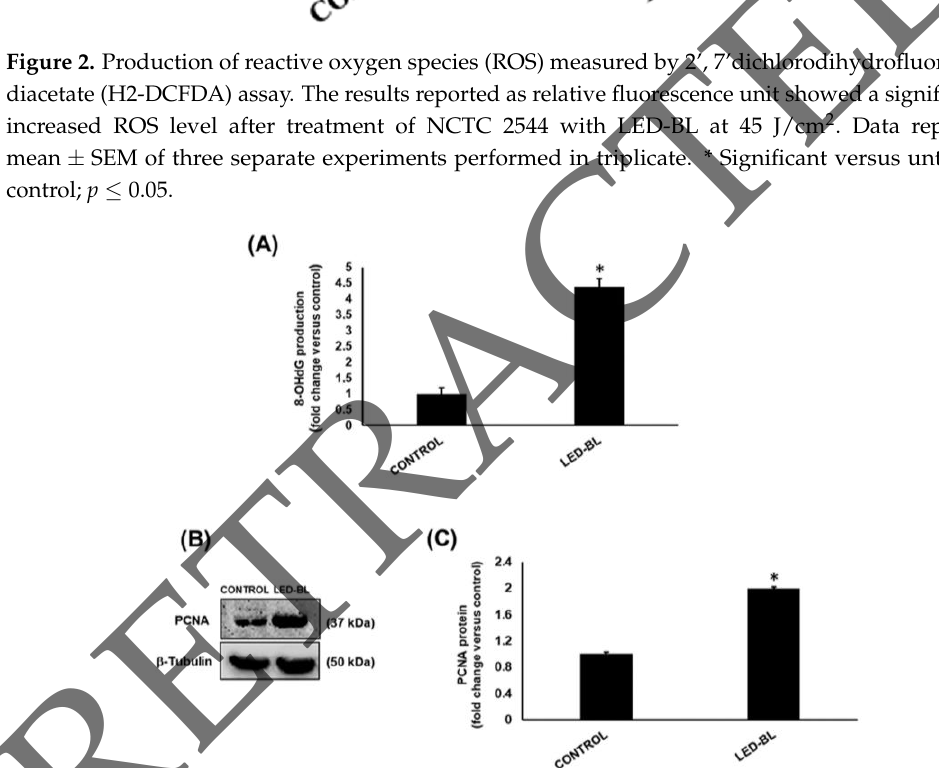
Figure 3. Determination ( A ) of 8-OHdG by immunofluorescence, and ( B , C ) of PCNA protein by Western blot in NCTC 2544 untreated or treated with LED-BL at 45 J/cm 2 . ( A , C ) protein expression calculated as fold change versus untreated control (Control); * significant versus untreated control; p ≤ 0.05.